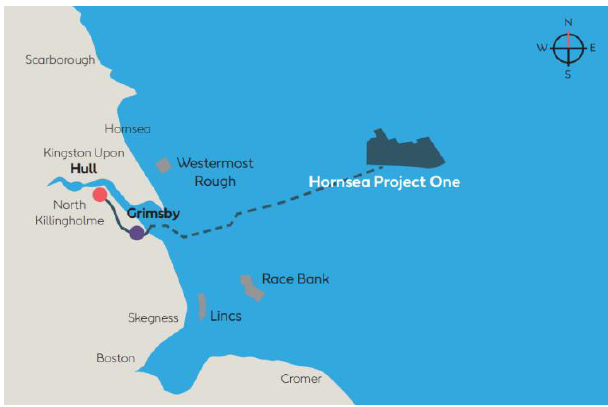
Figure 1. The location of the Hornsea wind farm.